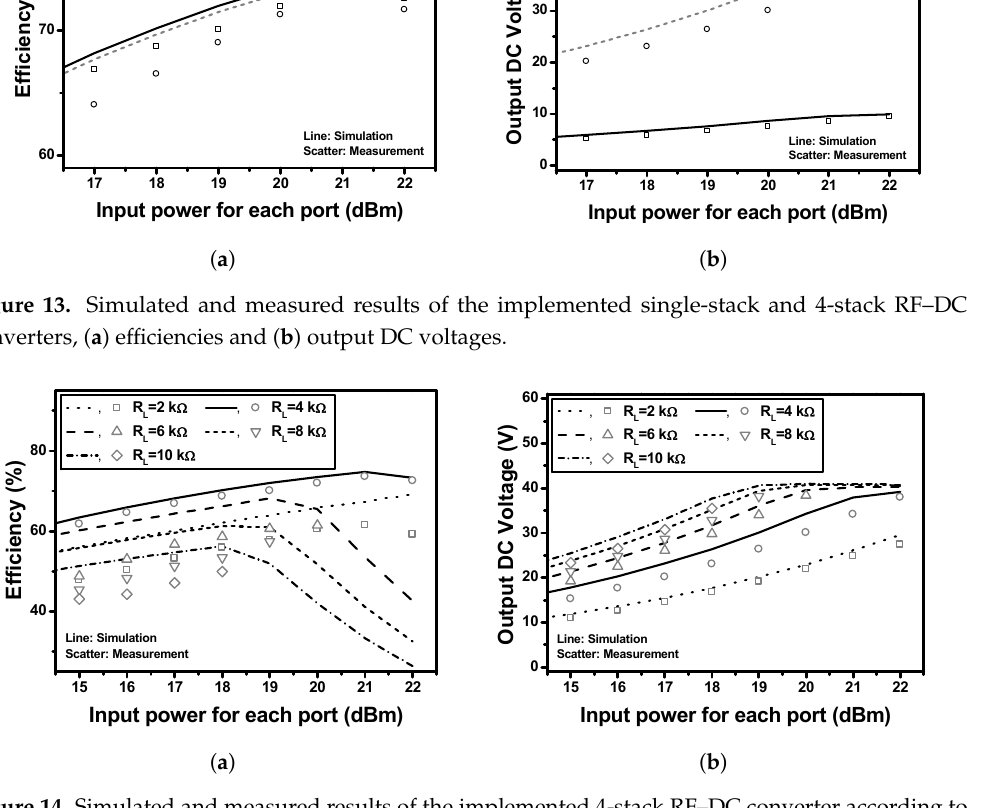
Figure 14. Simulated and measured results of the implemented 4-stack RF–DC converter according to the various load resistances, ( a ) efficiencies and ( b ) output DC voltages. Table 1. Performance comparison to the previous